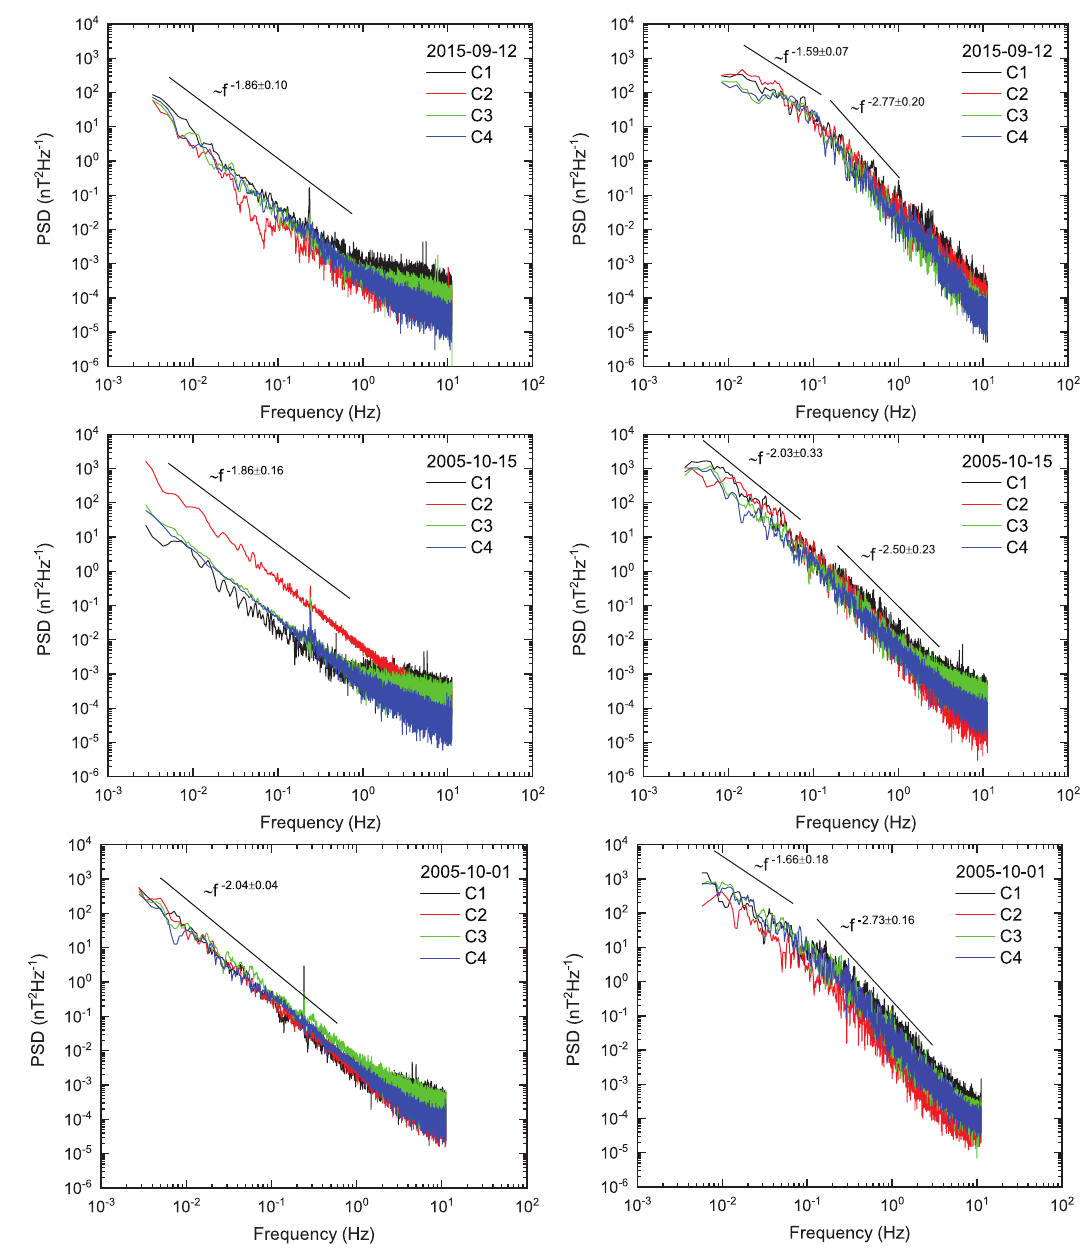
Figure 3. The results of spectral